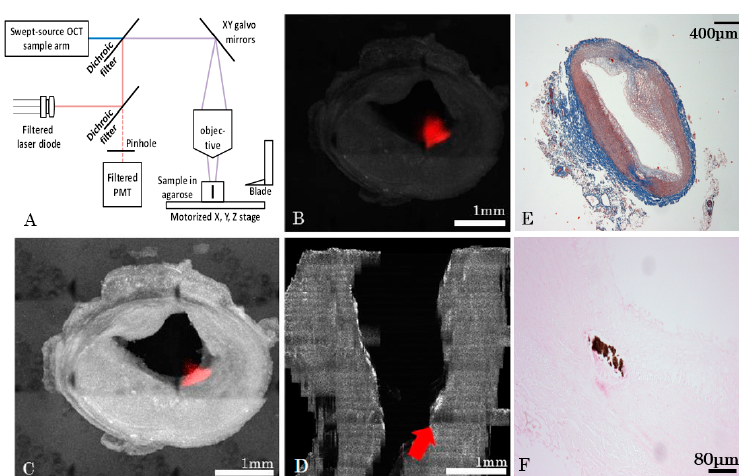
Figure 3. Ex vivo optical coherence tomography (OCT) and confocal reconstruction for a model 1-type rabbit. ( A ) Overview of the serial histology imaging system; ( B ) Example of an averaged slice (raw data) with the fluorescence image superimposed on it (i.e., red signal); ( C ) Example of the same slice after Beer-Lambert corrections, contrast adjustment, and deconvolution (Log-scale), with superimposed fluorescence image (red); ( D ) Localization of the tissue slice (c) on a 3D reconstruction (shown by red arrow); ( E ) Histology slice colored with Masson Trichrome and a 4 × objective ( F ) Same slice imaged with VonKossa and a 20 ×